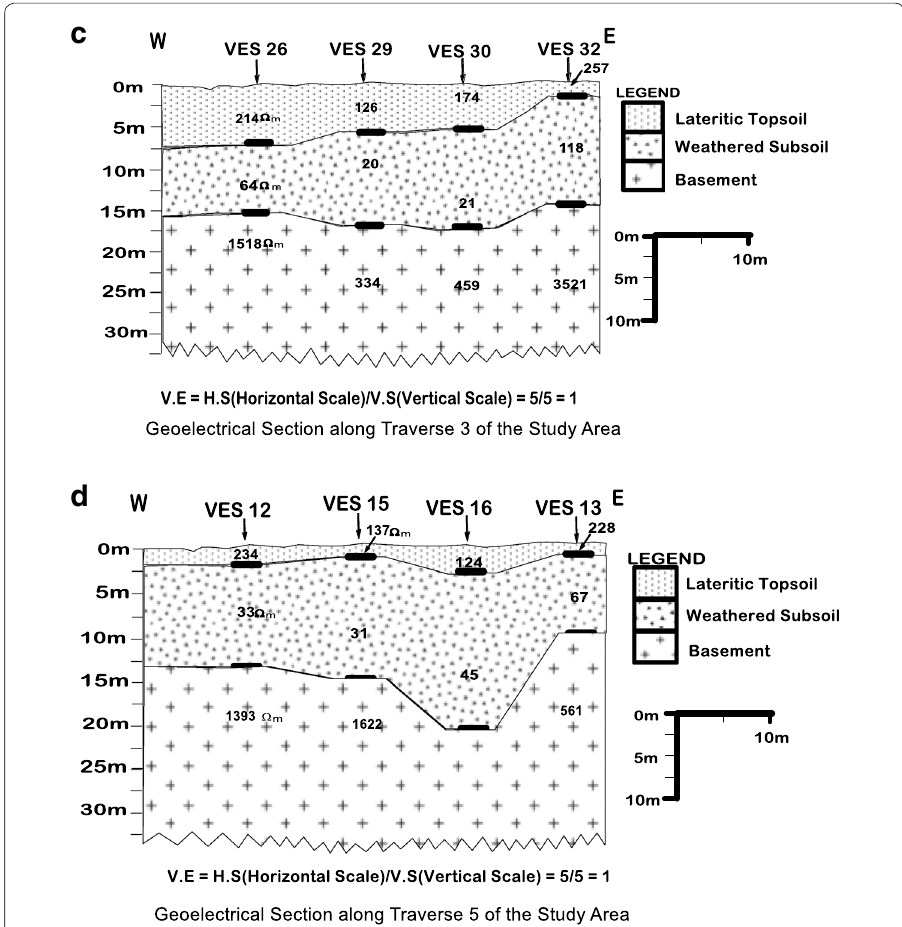
Fig. 7 Geoelectric sections along traverse 3 and